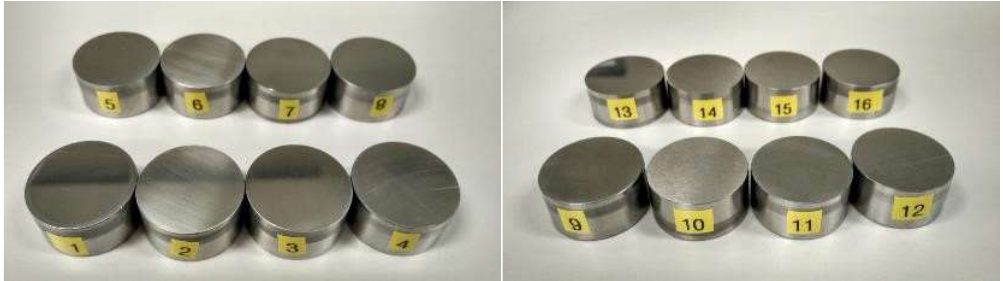
Figure 1. Test coupons for surface roughness measurement.